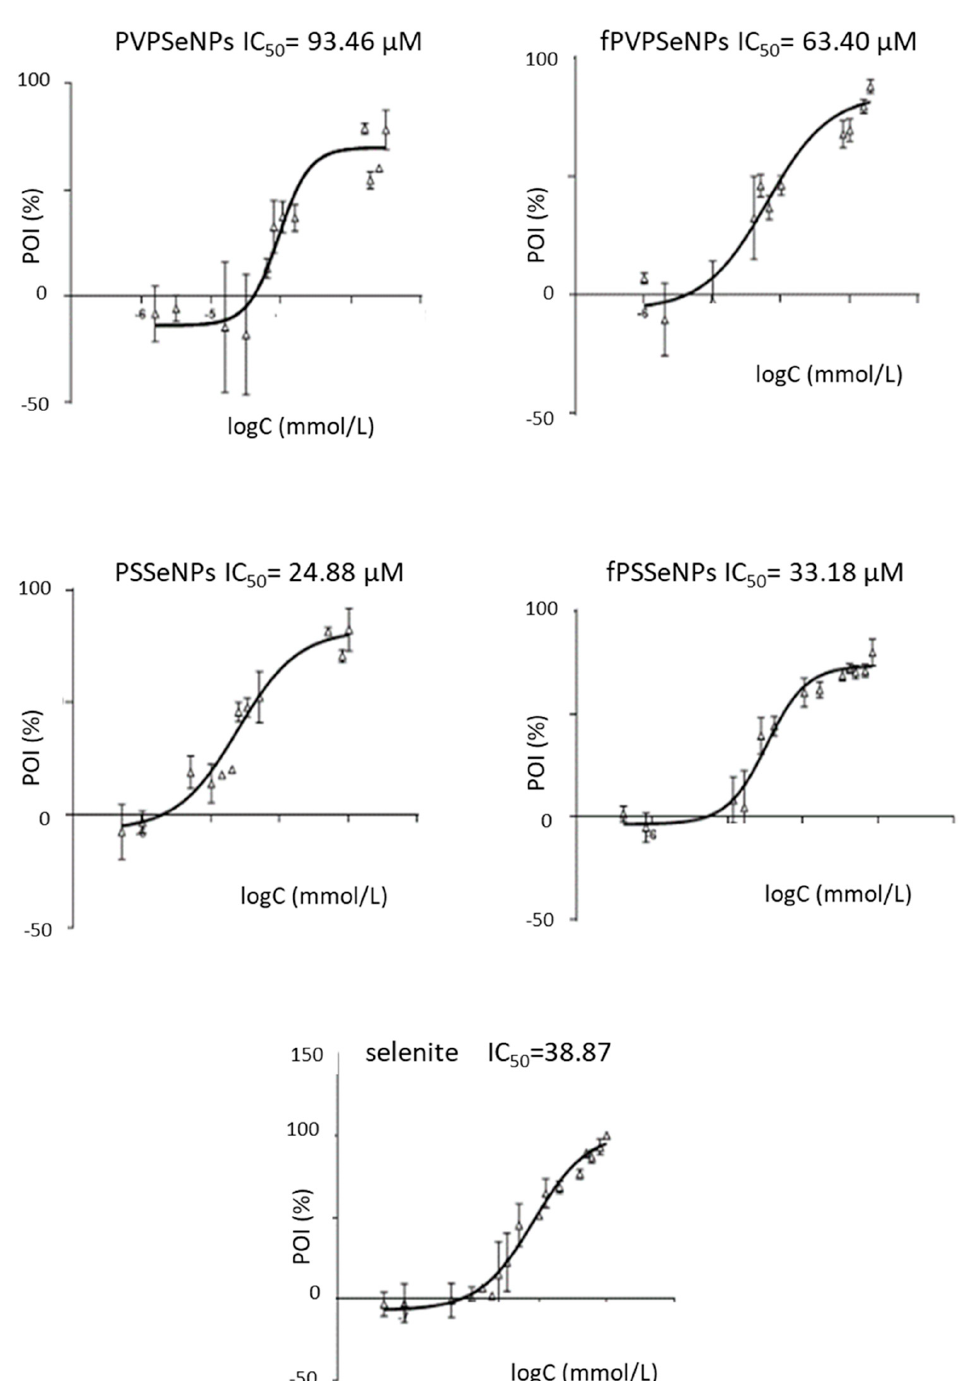
Figure 5. Cytotoxicity of different concentrations of selenium nanoparticles and sodium selenite on Caco2 cells. POI-percentage of inhibition; PVPSeNPs—selenium nanoparticles coated with polyvinylpyrrolidone; fPVPSeNPs—selenium nanoparticles coated with polyvinylpyrrolidone and functionalized with olive pomace extract; PSSeNPs—selenium nanoparticles coated with polysorbate; fPSSeNPs—selenium nanoparticles coated with polysorbate and functionalized with olive pomace extract.